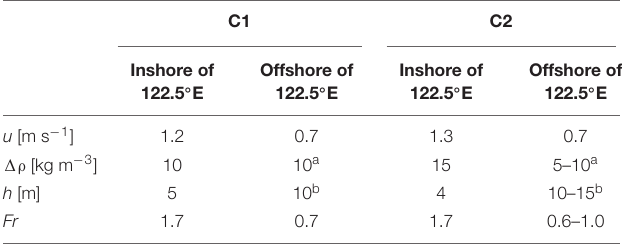
TABLE 1 | Values of the parameters used to calculate the Froude number Fr on different sections of Transect C1 and